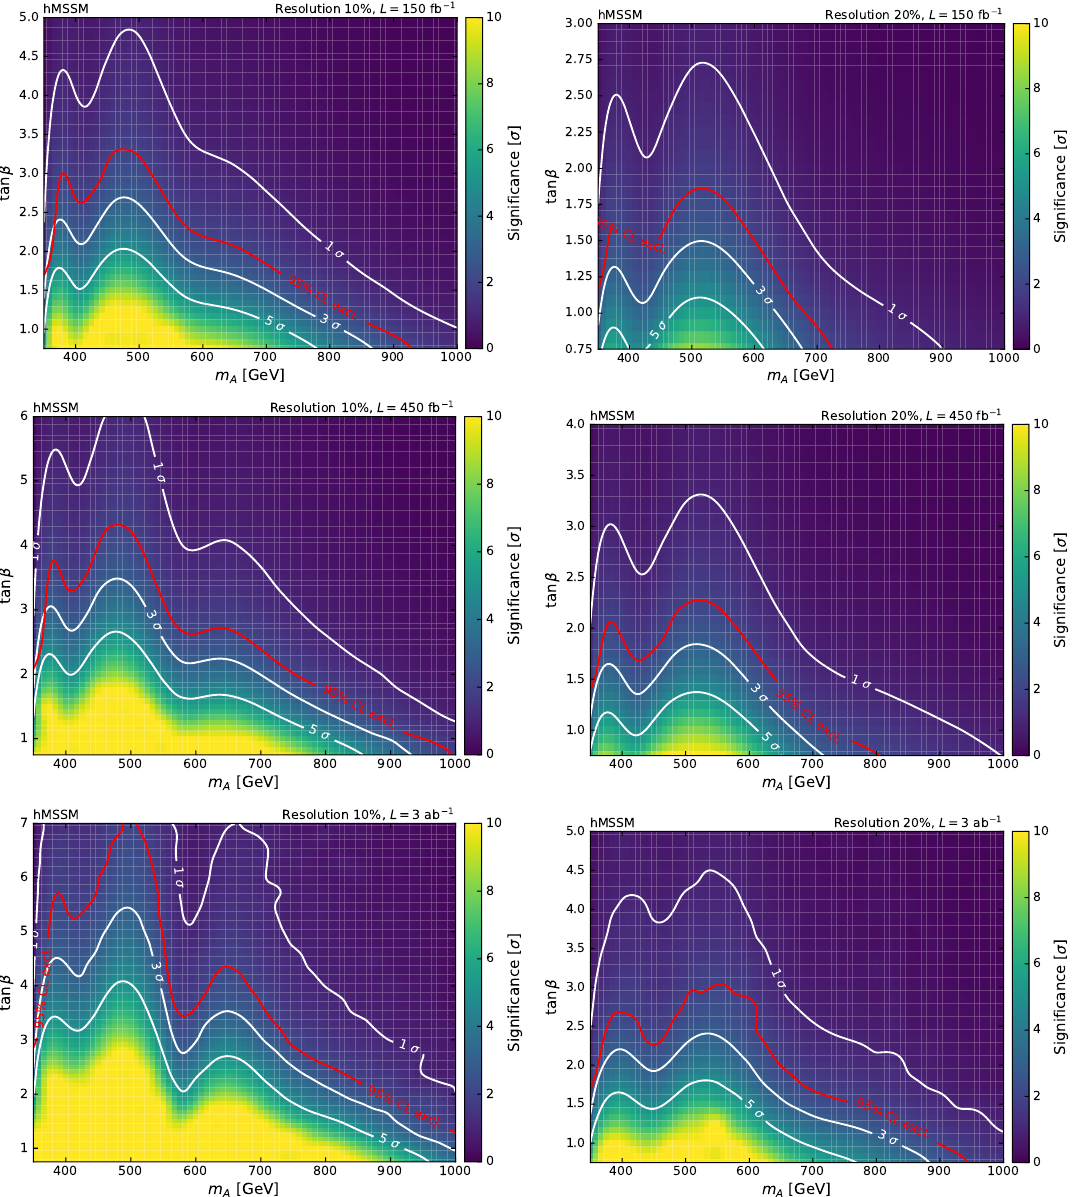
Figure 17 . Expected signi(cid:12)cance and exclusion potential for the hMSSM in the same six experi- mental scenarios as considered in (cid:12)gure 10. Values of signi(cid:12)cance in excess of 10 (cid:27) are clipped. A resolution of 10% and 20% is assumed for the left- and right plots,